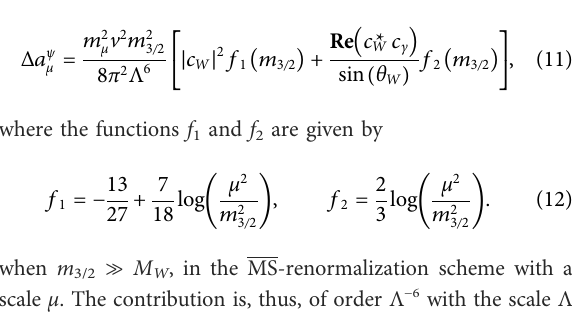
can fi x the renormalization scale μ to this value, one fi nds a corrected value given by Eq. (11) should be corrected by a factor 0.89.